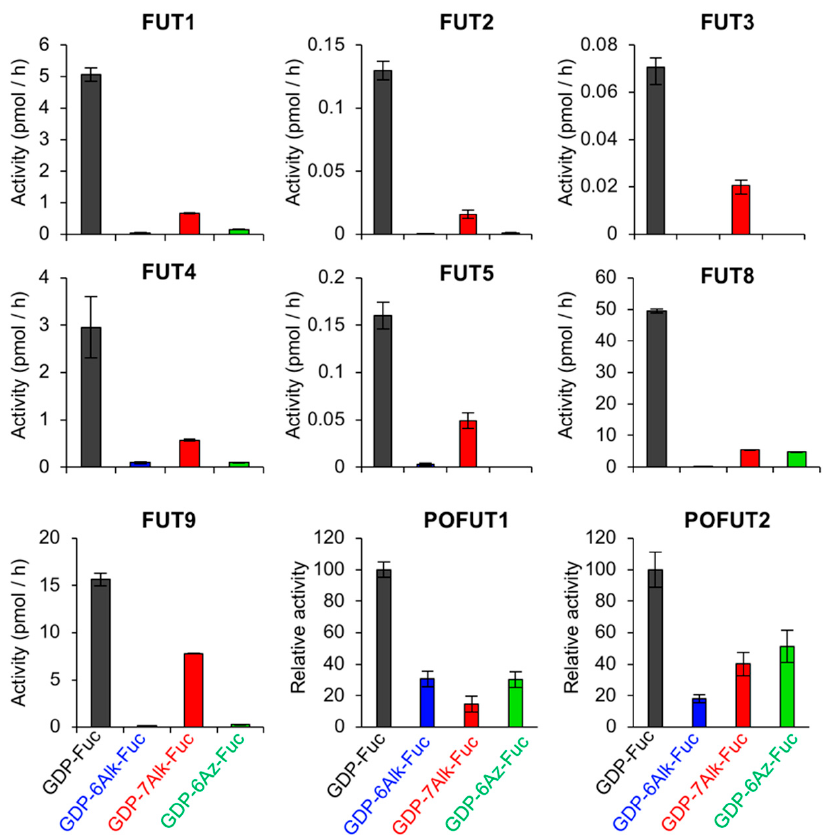
Figure 5. In vitro fucosyltransferase activity using GDP-Fuc and its analogs. Nine recombinant fucosyltransferases (FUT1, 2, 3, 4, 5, 8, 9, and POFUT1, and 2) were expressed and purified from mammalian cells. The activity of FUT1, 2, 4, 9 toward LNnT ( n = 3), that of FUT3 and 5 toward GGnGGnbi-PA ( n = 3), that of FUT8 toward GnGnbiAsn-PNS ( n = 3), that of POFUT1 toward EGF1 from human factor IX, and that of POFUT2 toward TSR3 from human Thrombospondin 1 were measured. All graphs show means ± SD.